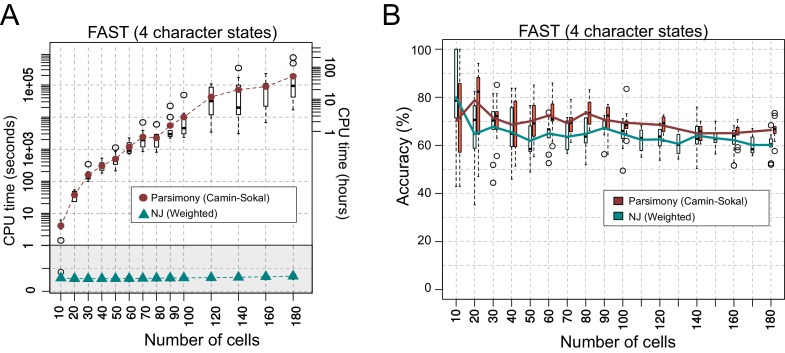
Comparing the performance of Neighbor Joining and Maximum Parsimony in lineage reconstruction.(A) CPU time (shown in seconds at the left and in hours at the right of the Y-axis) required for tree reconstruction with a given number of cells (X-axis). Boxplots show the distribution of times taken to reconstruct 10 trees. Brown circles and cyan triangles indicate the average CPU time for Parsimony and NJ, respectively. Each reconstruction was performed on a single CPU thread. (B) Accuracy of the reconstructed trees from A. The brown and cyan lines represent the mean accuracy of 10 trees for a given number of cells (X-axis) with their distributions shown as a boxplot.